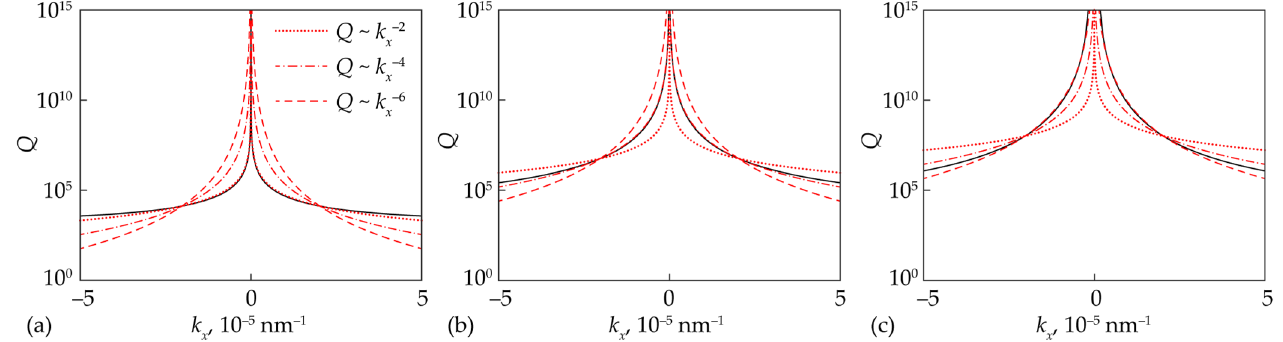
Figure 5. Rigorously calculated quality factors (solid black lines) of the eigenmodes as functions of k x ( a ) for the single grating near the BIC at k x = 0, ω = ω p2 , ( b ) for the stacked structure with l = 6.522 µ m near the BIC at k x = 0, ω = Re ω p1 , and ( c ) for the stacked structure with l = 6.469 µ m near the BIC at k x = 0, ω = ω p2 . Dotted, dash-dotted, and dashed red lines show the k − 2 x , k − 4 x , and k − 6 x decay laws, respectively.